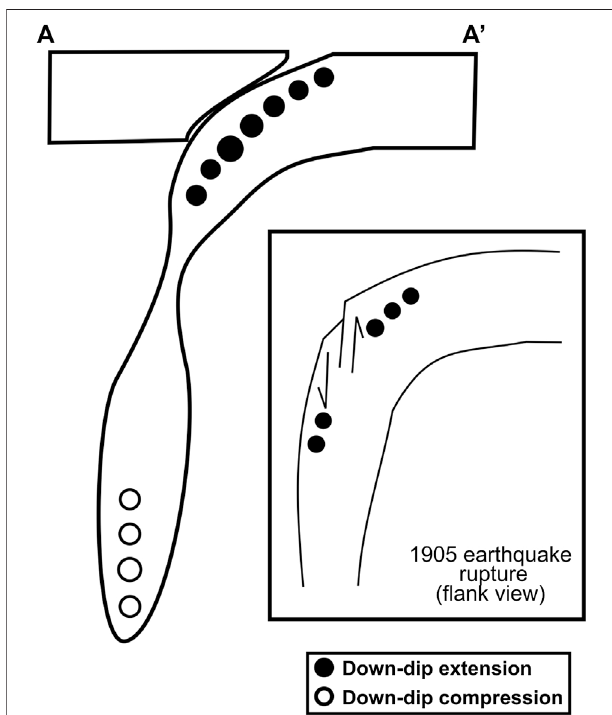
FIGURE2| Cross-sectionsketchviewofthesubductionsystemalonga NW-SE pro fi le crossing southern Calabria approximately indicated as AA ′ in Figure 1 . The fi gure shows the present-day state of subduction beneath Southern Calabria in the reconstruction given by Presti et al. (2019). Clear necking of the founding slab has occurred at a depth of ca. 150 km but slab detachment has not happened, yet. The upper part of the slab located above the necking zone is subjected to down-dip extension under its own weight. This may generate seismic effects like those observed in 1905 when the upper, elbow zone of the slab ruptured, producing the magnitude 7.5 earthquake of southern Calabria [a sketch of this process redrawn from Presti etal.(2017),withmodi fi cations,isreportedintheinsetofthis fi gure].The1905 ruptureoccurred on ahigh-dip plane parallel tothe SW-NE subduction trench orientation, with the most advanced northwestern part of the slab slipping down with respect to the southeastern part (Presti et al.,